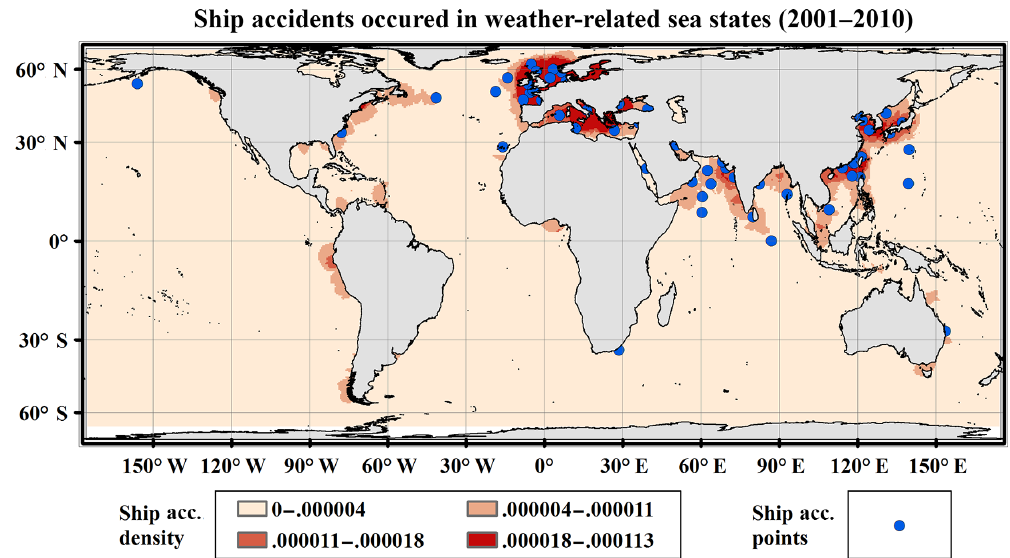
Figure 2. Geographical distribution of the ship accident density according to the 755 weather-related cases. The superimposed blue dots indicate the ship accidents (58 cases) that occurred in a swell sea